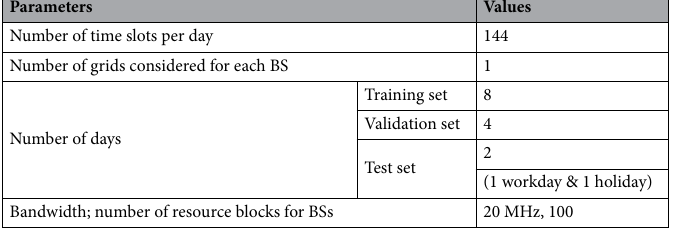
Table 2. Experimental